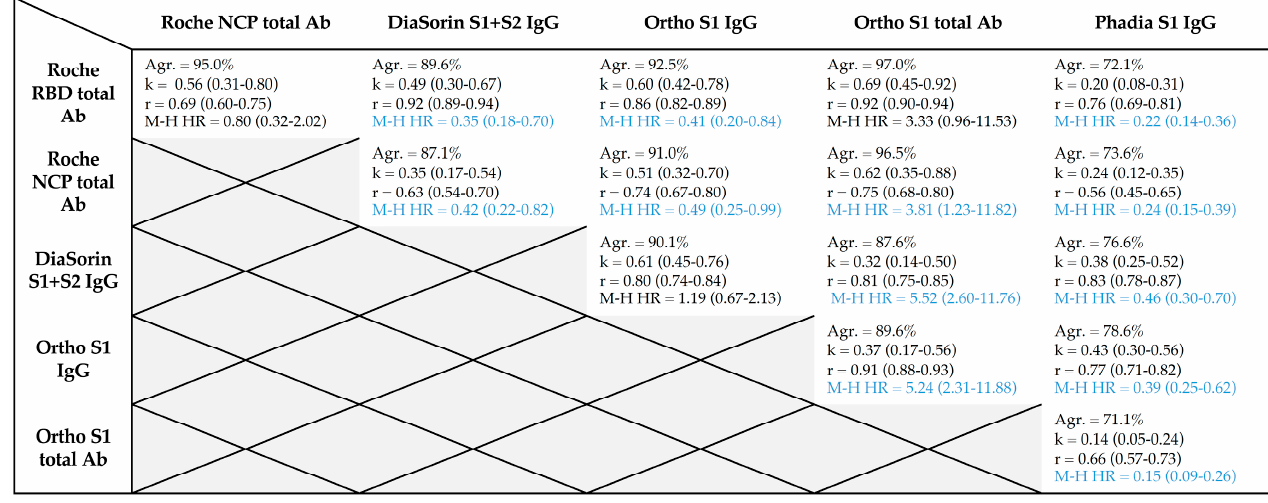
Table 4. Agreement (Agr.), Cohen’s kappa index (k), correlation (r) and Mantel–Haenszel hazard ratios (M–H HR) between the different assays. Results in blue are statistically significant.